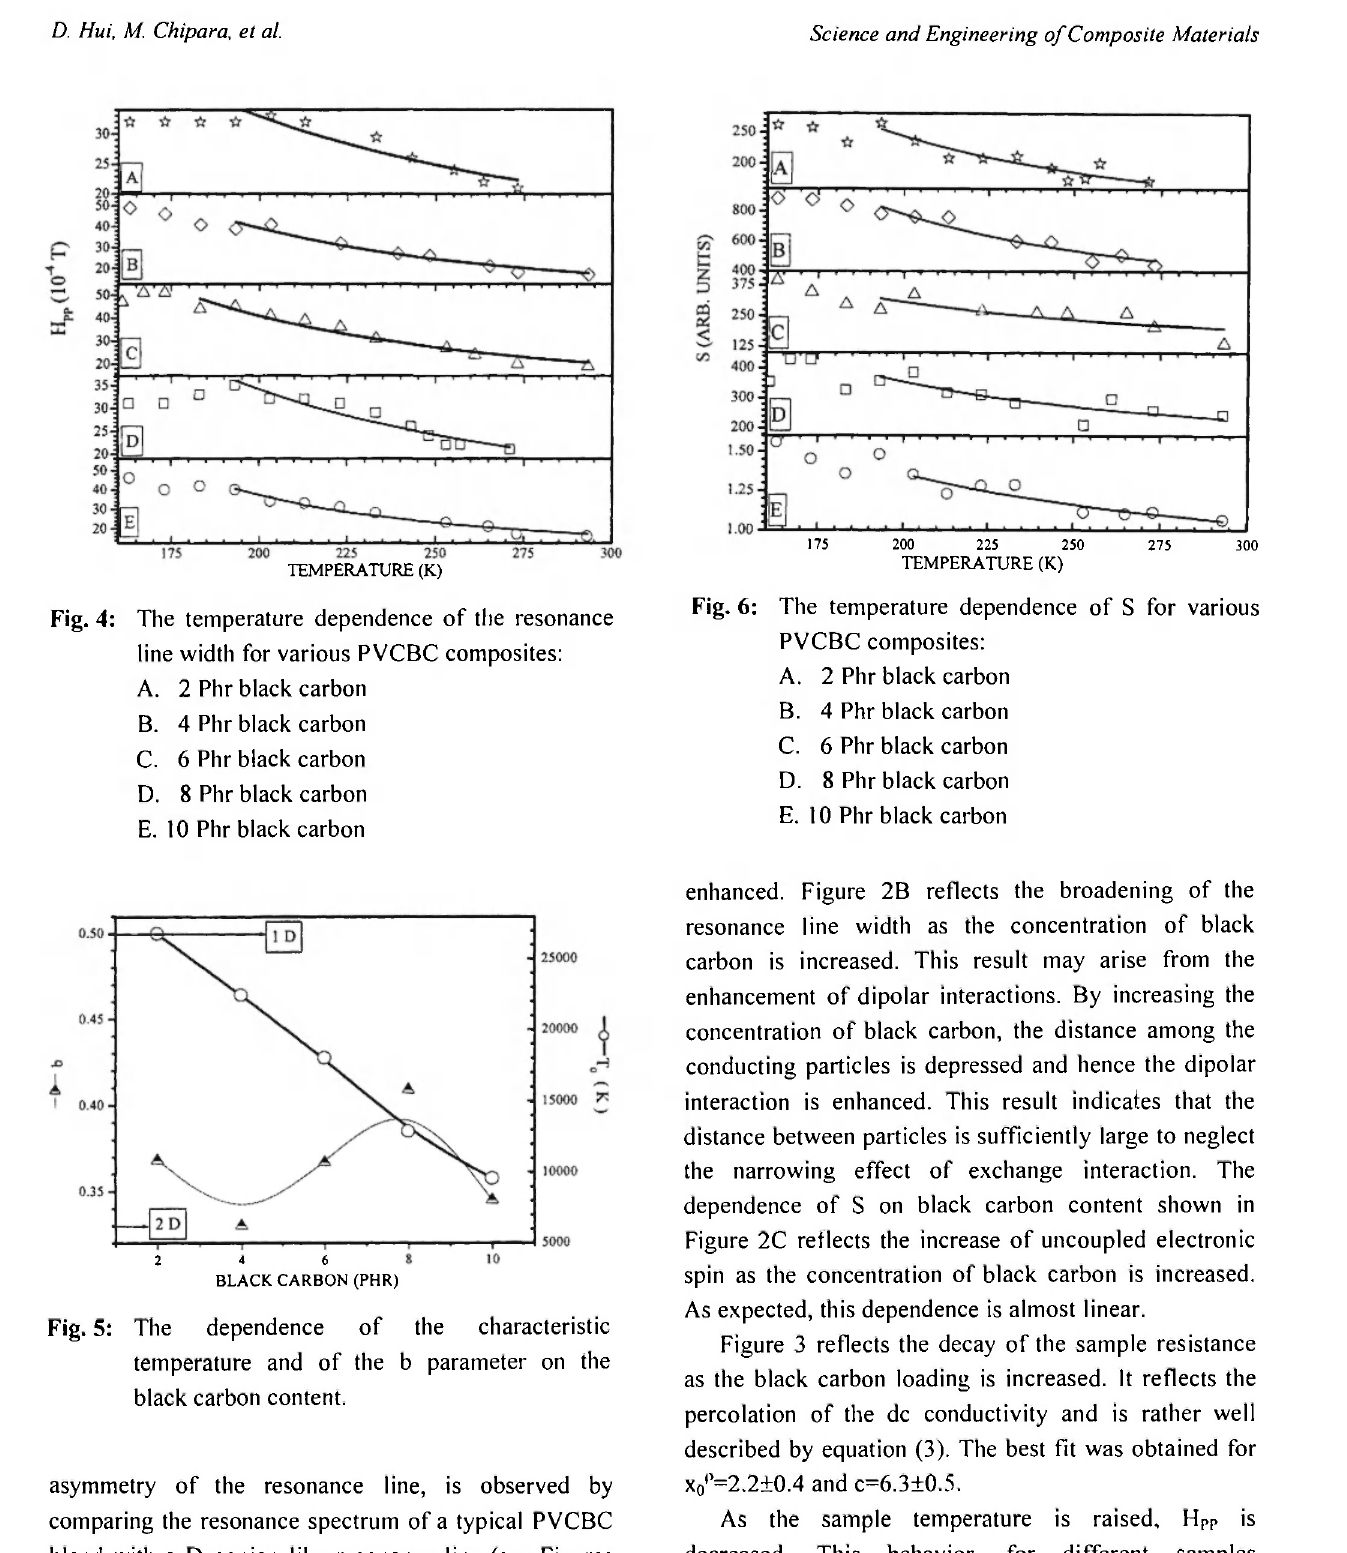
Fig. 5: The dependence of the characteristic temperature and of the b parameter on the black carbon content.